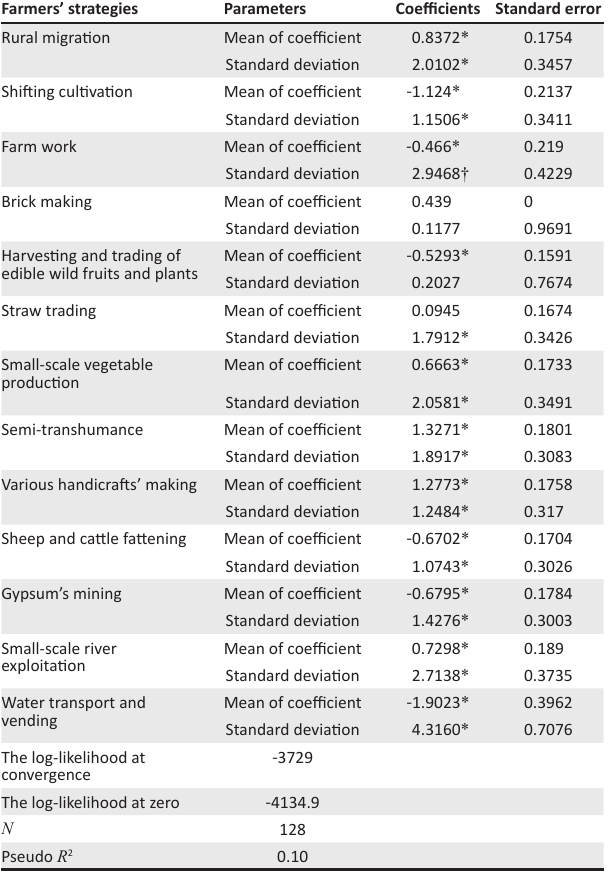
TABLE 3: The multinomial mixed logit estimates based on farmers’ adaptation strategies against climate change. Farmers’ strategies